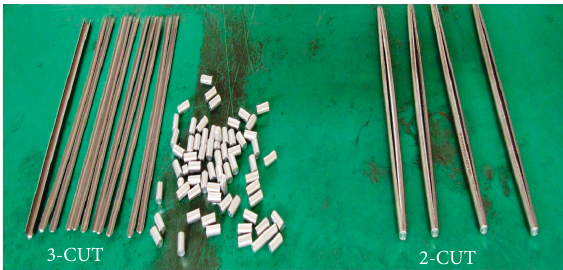
Figure 7: Slitting shapes of 2-CUT and 3-CUT